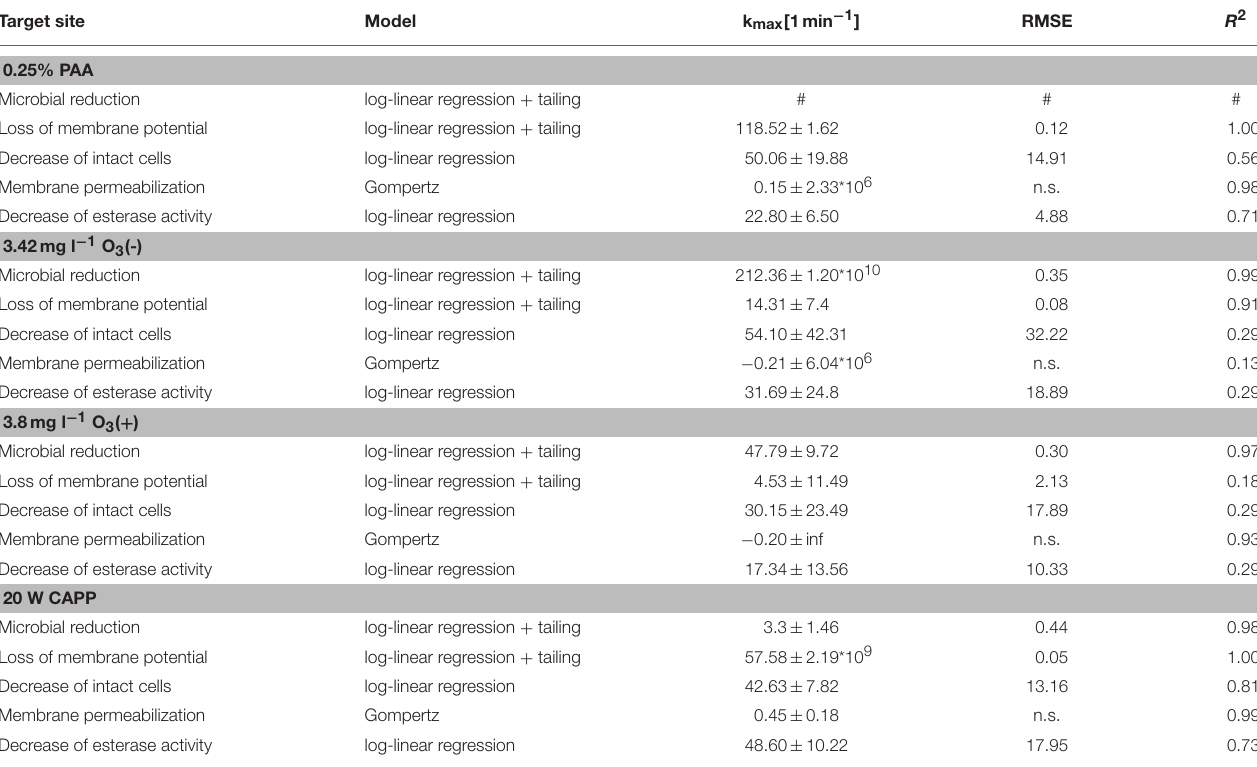
TABLE 6 | Statistical measures and parameter values obtained from GInaFit Version 1.6 and SigmaPlot13 for experimental data of inactivated L.